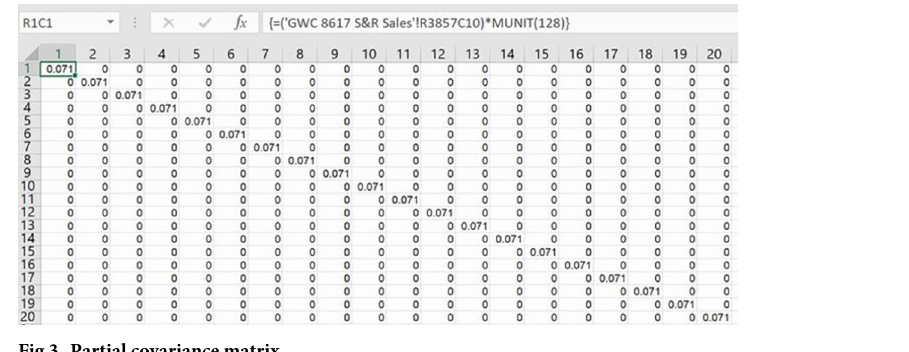
Fig 3. Partial covariance